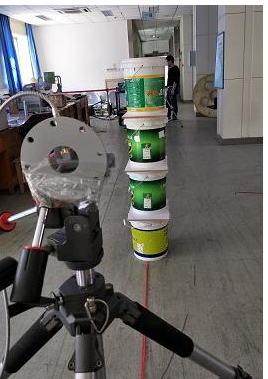
Figure 1. Experimental scene.